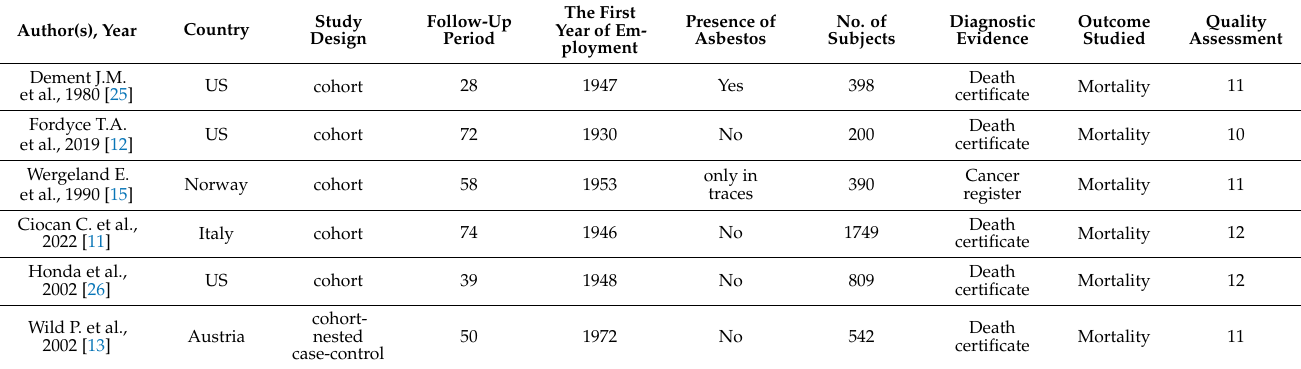
Table 3. Included cohorts’